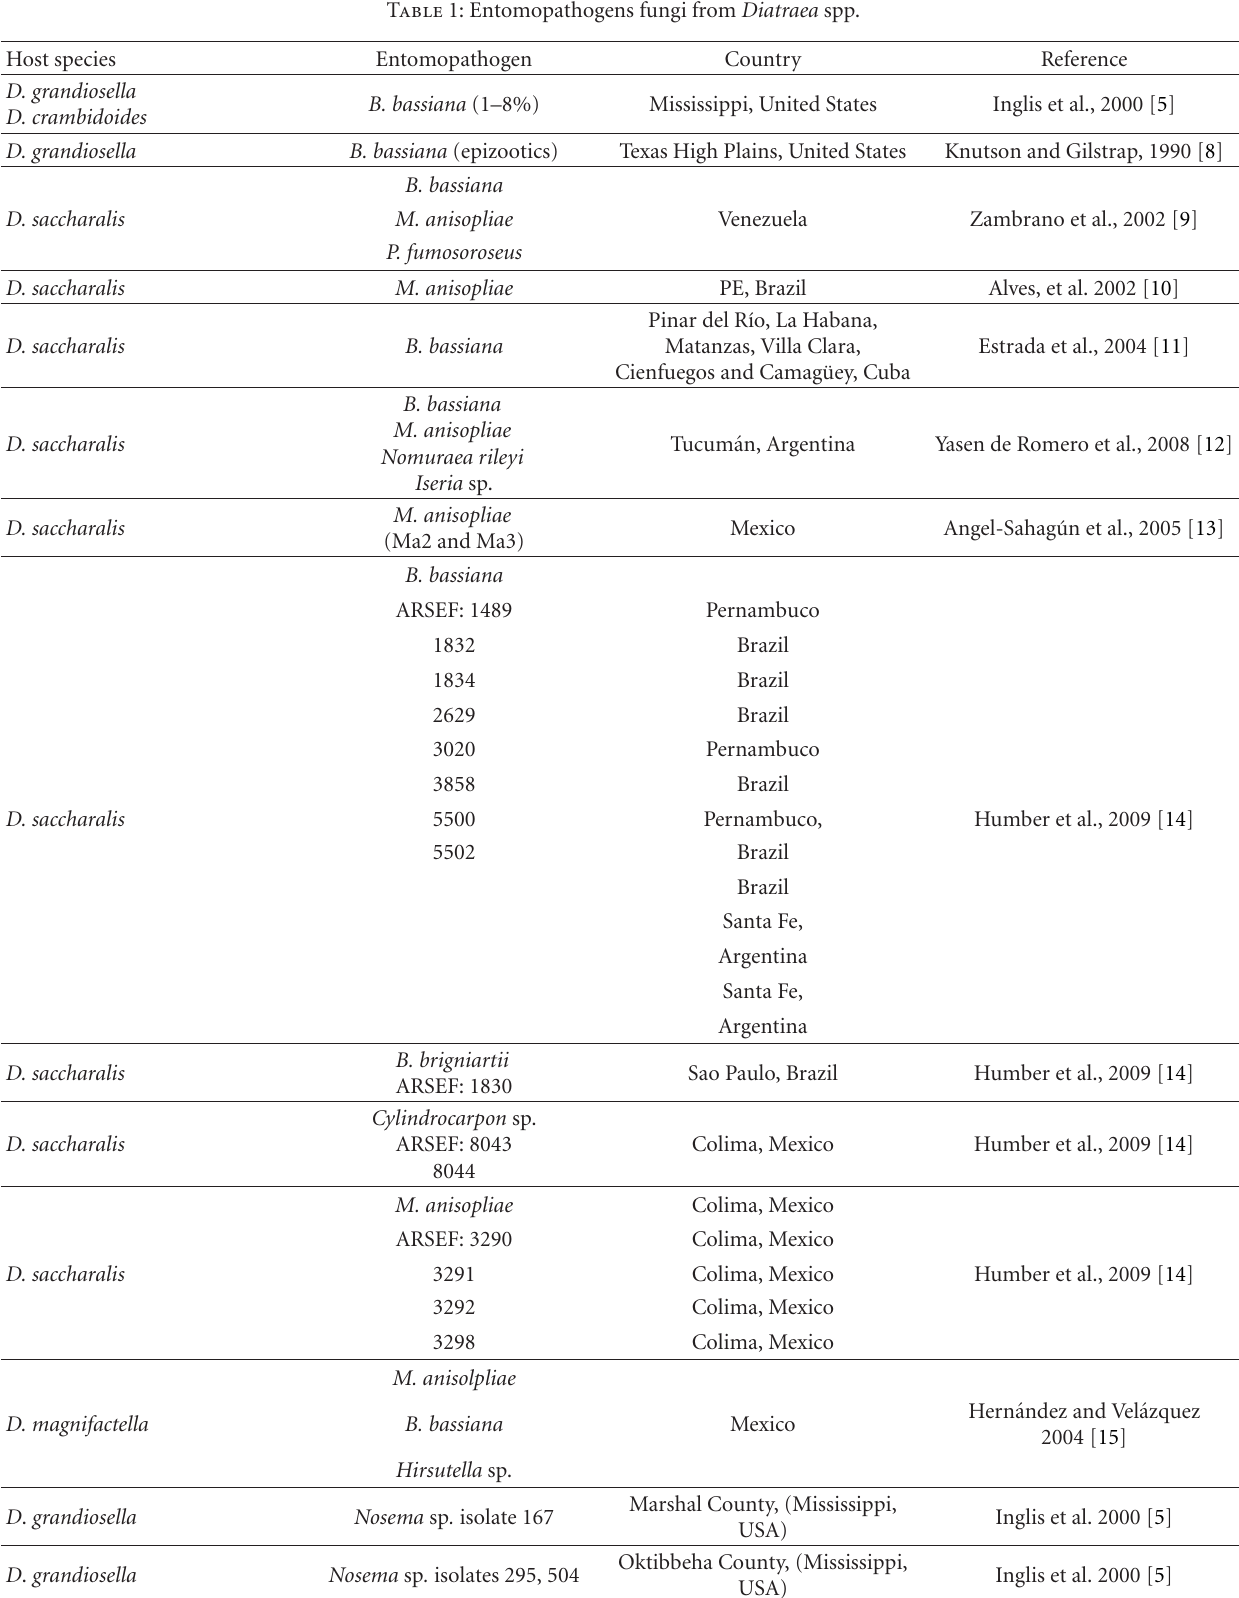
Table 1: Entomopathogens fungi from Diatraea